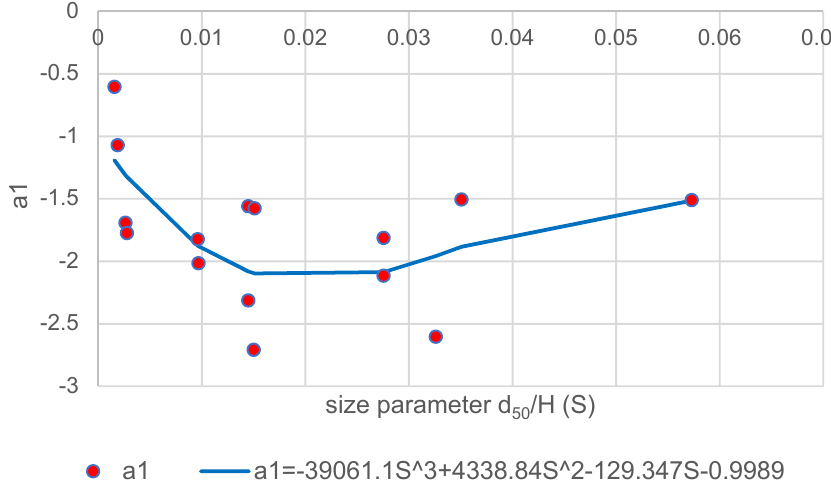
Figure 10. Size parameter vs. coefficient a 1 using decision trees ( R 2 = 0.4313 ).